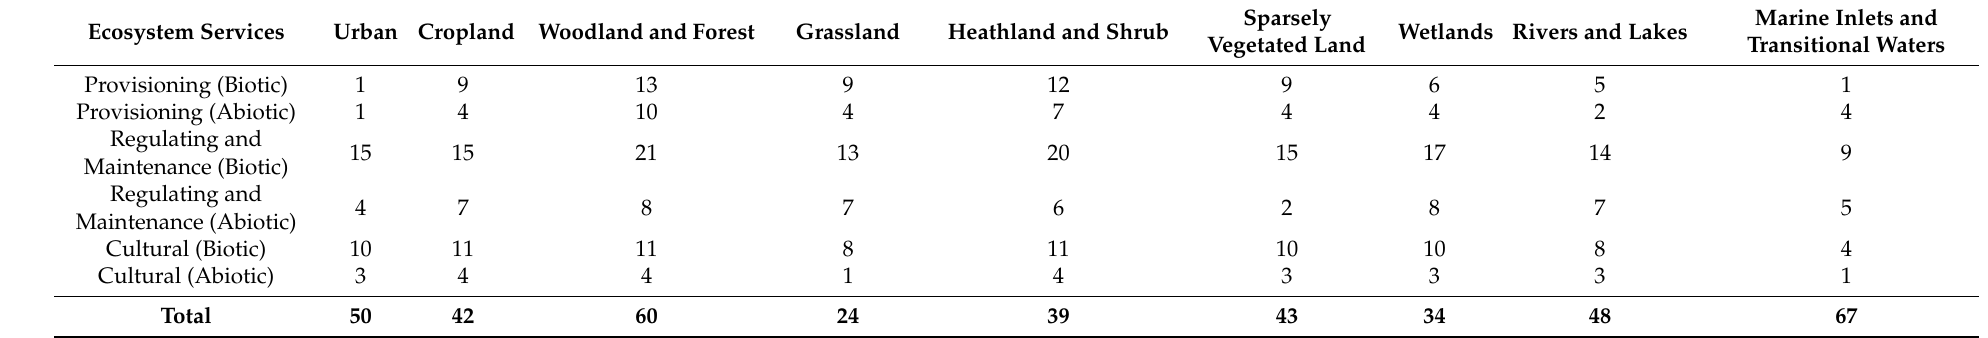
Table 5. Number of different ecosystem services per ecosystem services major categories [36] and per MAES level 2 ecosystem type. Ecosystem Services Urban Cropland Woodland and Forest Grassland Heathland and Shrub